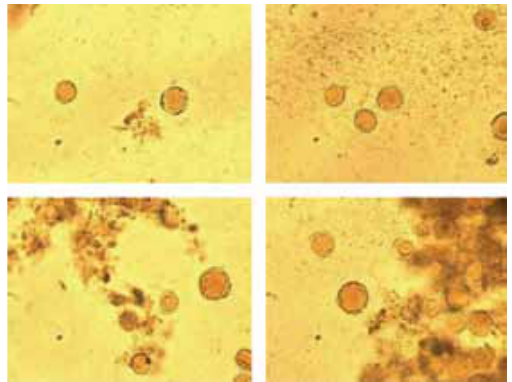
FIGURe 1. Blastocystis hominins cyst-like in a wet mount stained in iodine (vacular form)